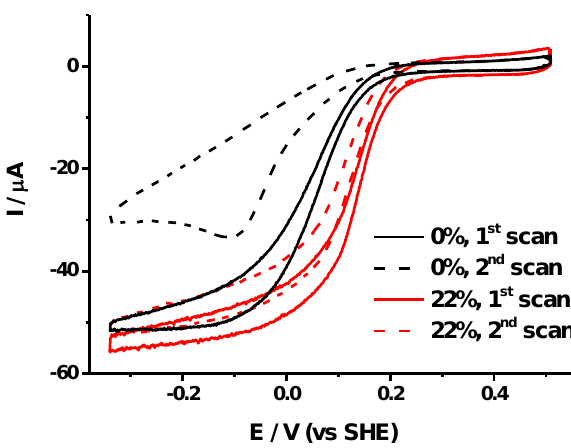
Figure 1. Two consecutive voltammograms obtained for partially delipidated cytochrome bd oxidase (black plots) and the same preparation reconstituted with 22% phosphatidylglycerol / phosphatidylethanolamine (PG / PE) (1 / 1) (red plots) on gold nanoparticles (NPs) modified with HT / MCH (1 / 1). Table 1. Half wave catalytic potential (E cat ), slope of the limiting current ( ∆ i / ∆ E) and variability of the limiting current value between two consecutive scans separated by 10 min ( ∆ i / i), obtained for the di ff erent immobilization conditions tested in this study. Standard error of measurements (SEMs)